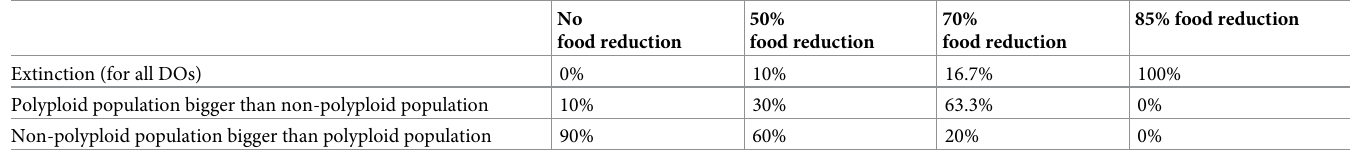
Table 1. Summary of results from evolution simulation experiments under a scenario of dynamic food reduction. For every food reduction group, 30 simulations were run for up to 2000 time steps, or until either the polyploid or non-polyploid subpopulations become